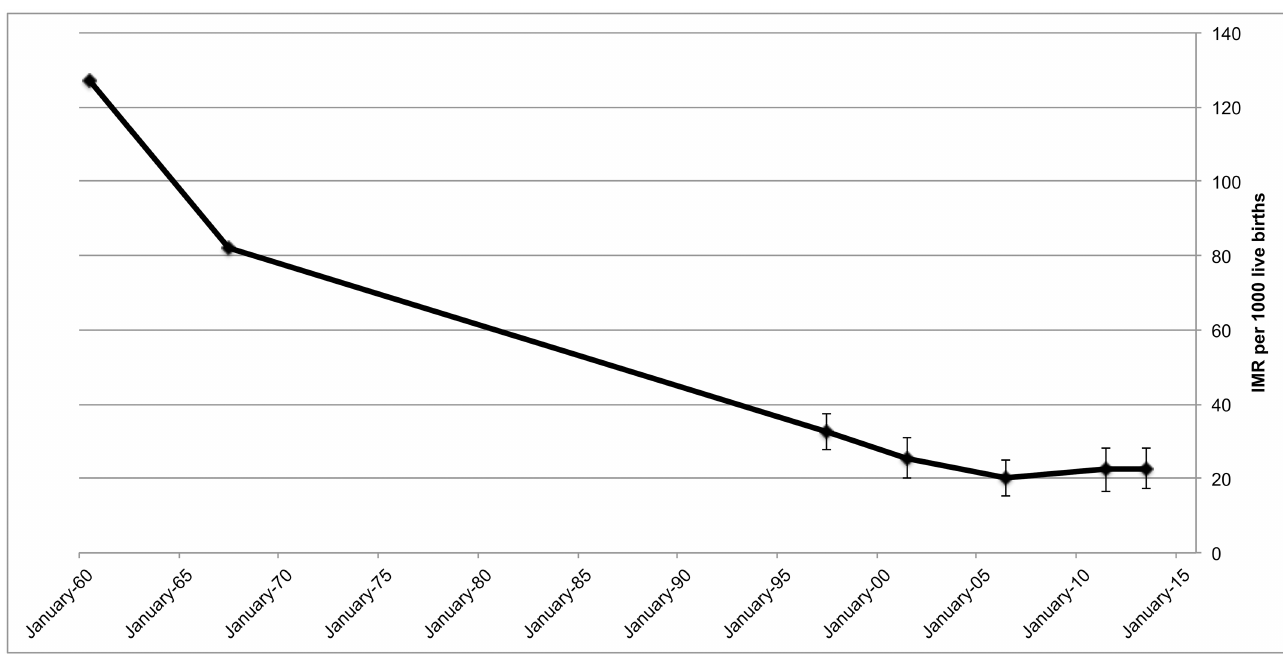
Fig 1. Trend of infant mortality rates among Palestine refugees in Gaza since 1960. The preceding birth-technique was used in 1997, 2003, 2008, 2013 and 2015 surveys, with reference periods from 1995, 2001, 2006, 2011 and 2013 respectively.[1–4] In 1960 and 1967 a different methodology was used. Sources UNRWA